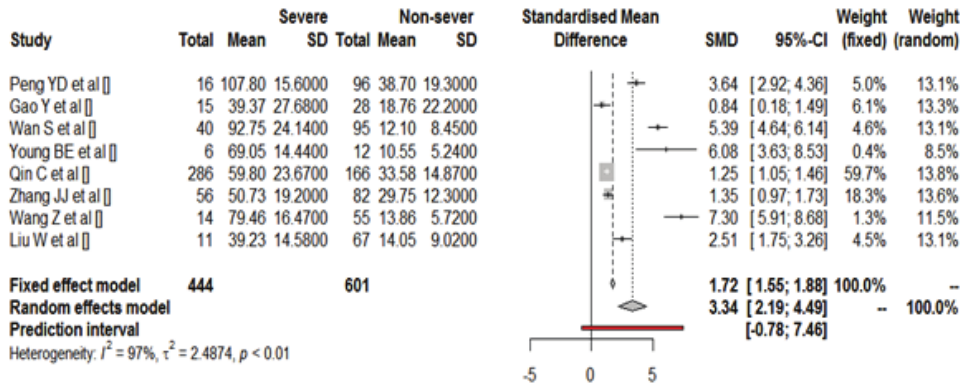
Figure 3: Pooled SMD of CRP estimates between the two groups of patients (severe and non-severe COVID-19).